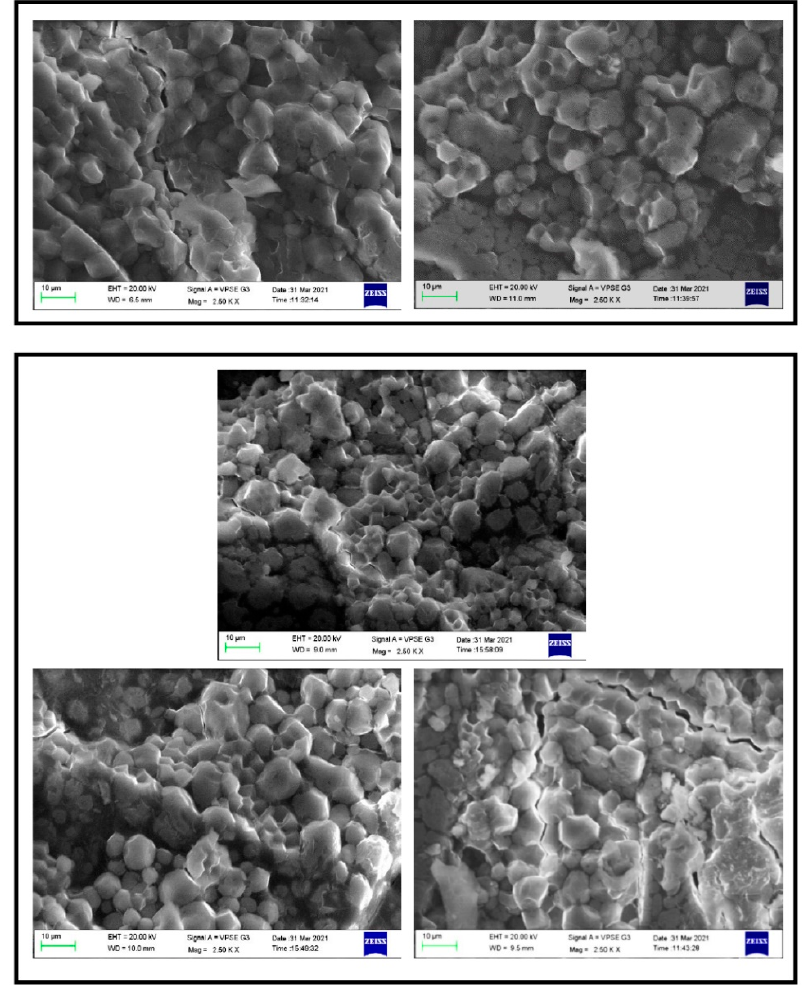
Figure 11. Structural differences in molecular starch of rice at SEM magnification of 2.5 KX for transverse section of grains of wild types of MTU-1010, PB 1509, and Cas9-free knockouts of SSSII-1, 2, and 3 .